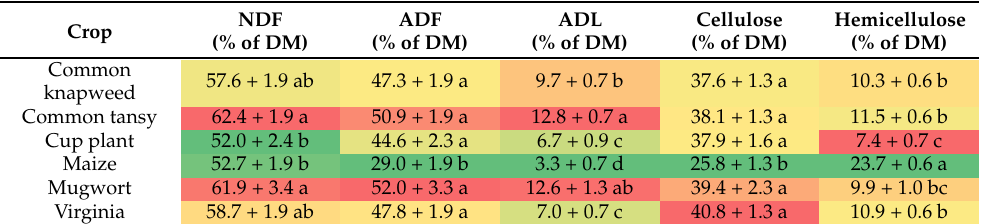
NDF = neutral detergent fiber, ADF = acid detergent fiber, ADL = acid detergent lignin, DM = dry matter, n = number of field replicates. Different lower case letters denote for significant ( p < 0.05) differences